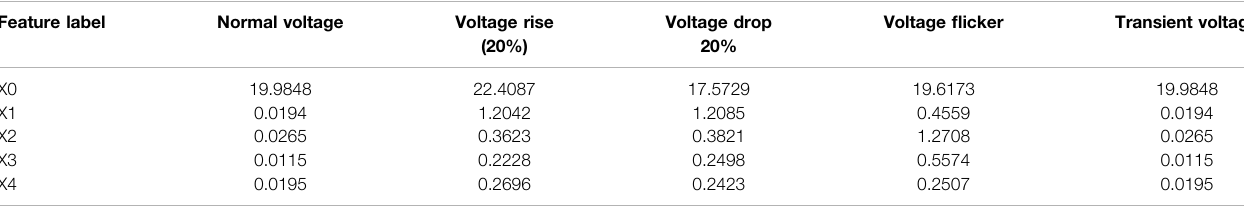
TABLE 1 | Feature values of different power quality